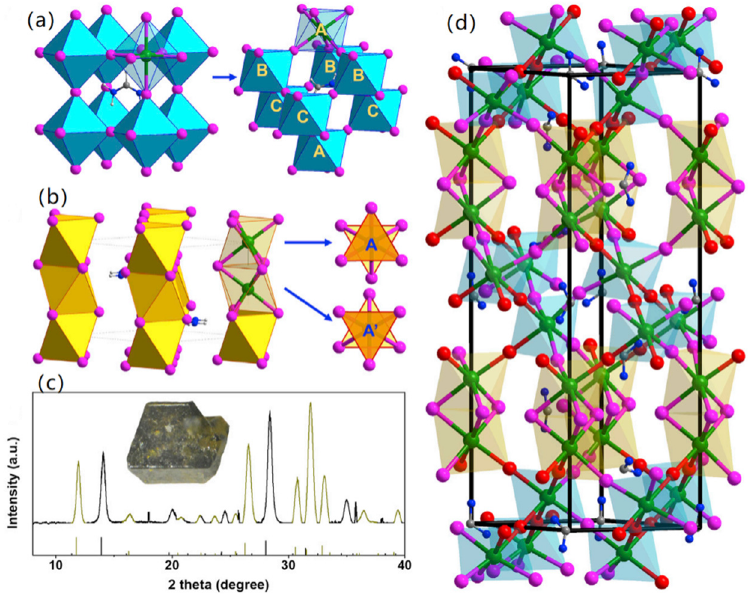
Figure 4. ( a ) Structures of α -phase FAPbI 3 along different axis ([100] and [111]); ( b ) Structures of δ -phase of FAPbI 3 along the [0001] axis and A and A’ were the two types of [PbI 6 ] octahedrons. ( c ) XRD of a 3C-FAPbI 3 single crystal with a phase transition; ( d ) Structure of 8H-FAPbX 3 . Br (Red); I (purple); Pb (green); N (blue); C (gray); H (white). Reprinted with permission from Ref. [52]. Copyright 2021 Elsevier.